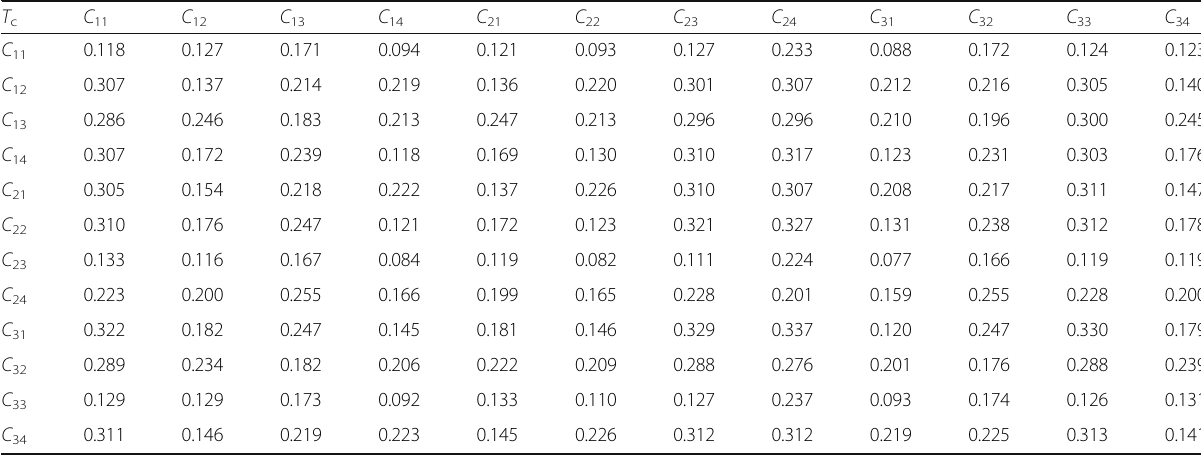
Table 2 Total influential effect matrix T c of criteria T